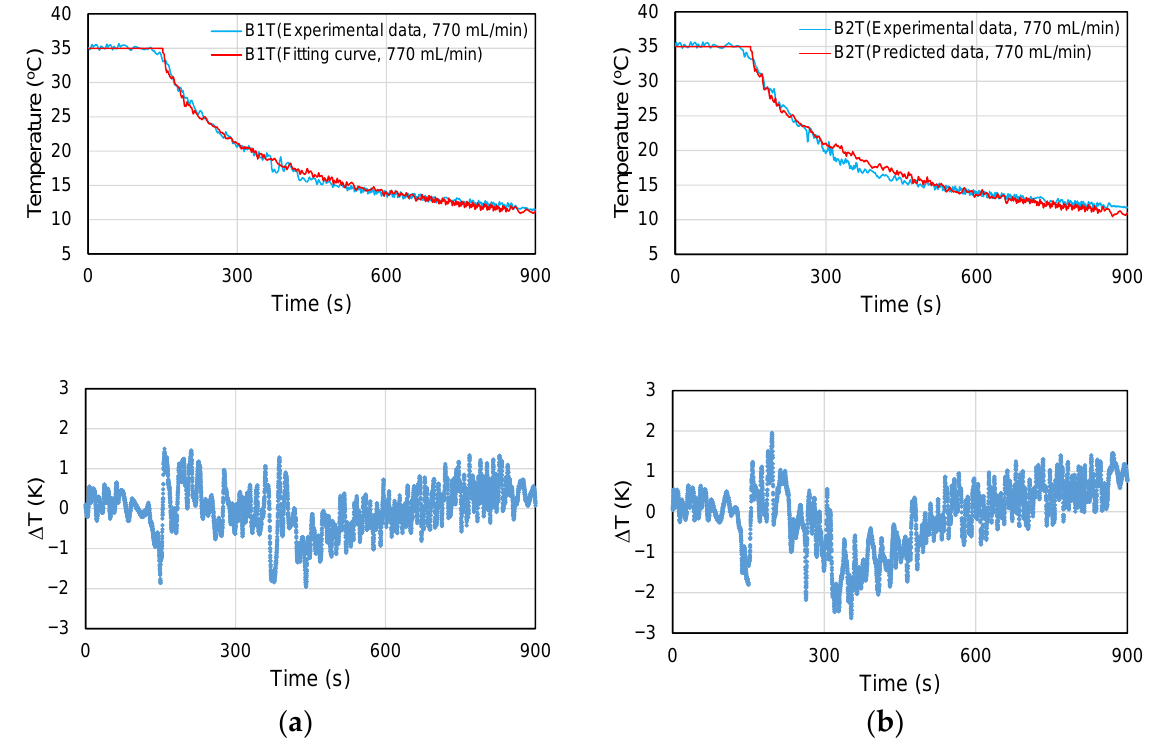
Figure 7. Model training and validation of the top layer at location B under the initial temperature of 35 °C and flow rate of 770 mL/min: ( a ) training; ( b ) validation. Table 3. The coefficients, R 2 , and MAE of the model for the top layer at the flow rate of 770 mL/min. Initial